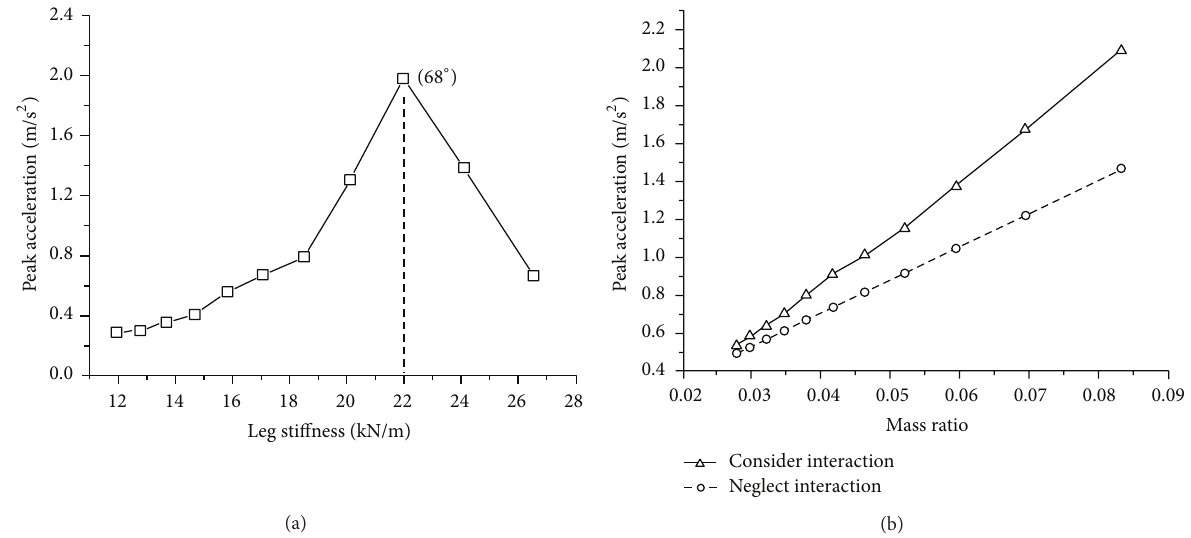
Figure 12: Effect of leg stiffness (a) and human/structure mass ratio (b) on the response of the beam structure.